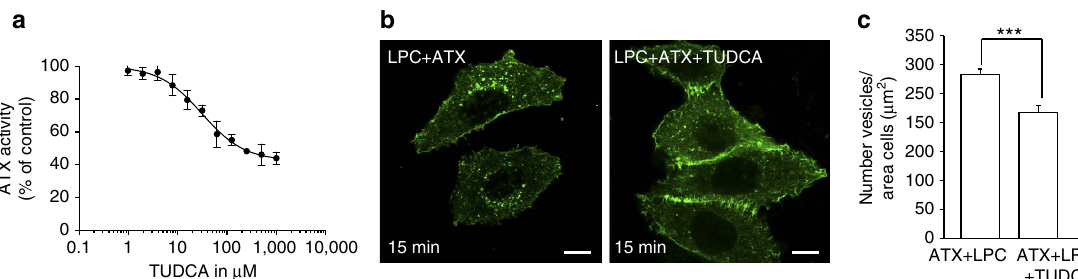
Figure 6 | Physiological effects of bile salts on human serum and LPA receptor activation. ( a ) Inhibition of lysoPLD activity is human serum supplemented by TUDCA, measured as released choline by LPC(18:1) hydrolysis. The error bars represent s.e.m. from three different samples. ( b ) Representative confocal images of untreated and TUDCA-treated HeLa cells transfected with GFP-LPA 1 ; the number of GFP-LPA 1 -containing endosomes is lower in TUDCA-treated cells. Scale bar, 10 m m. ( c ) Quantification of LPA 1 internalization shows that TUDCA reduces the number of endosomes compared with untreated cells; error bars correspond to s.e.m. from 27 images in two independent experiments; *** P o 0.001 according to Student’s t acting as allosteric modulators of ATX activity, with potential physiological and clinical implications.